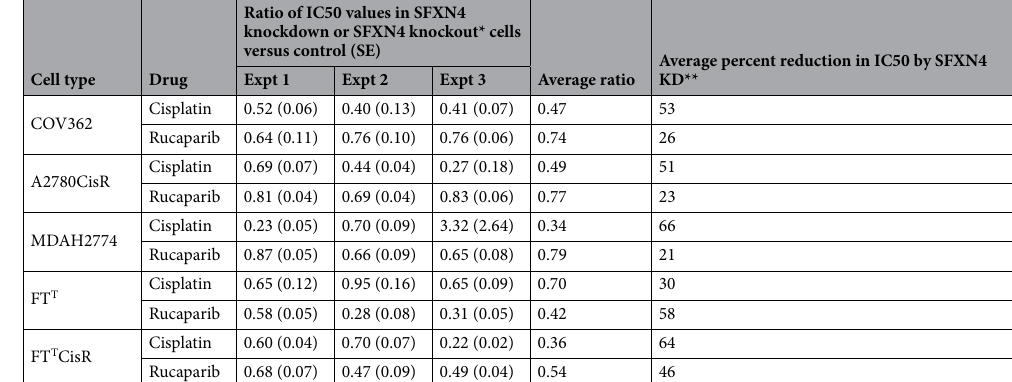
Table 1. Effect of SFXN4 knockdown on drug sensitivity of ovarian cancer cells. *SFXN4 levels were reduced by knockout in MDAH2774 and FT T cells and by siRNA knockdown in other cells. **Percent reduction in IC50 by SFXN4 knockdown or knockout was statistically significant (p < 0.0001) in all